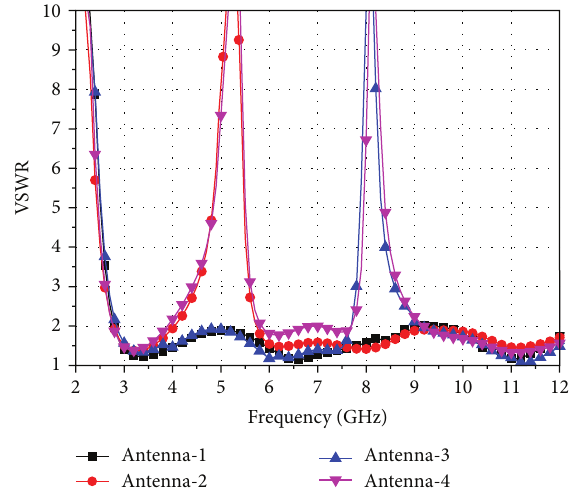
Figure 2: Band-notched characteristic of the four antennas while antenna-4 is with all the switches